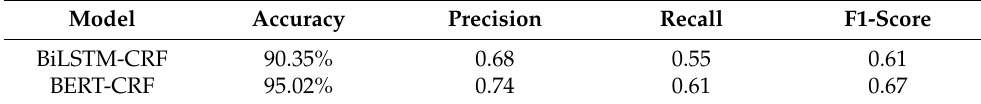
Table 2. Comparison of performance using BiLSTM-CRF and